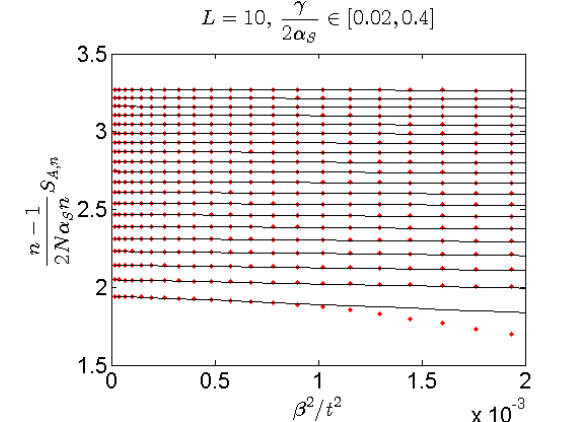
Figure 11 . Comparison of the numerical result (red dots) with the long time asymptotic behav- ior (5.19) (black lines) for L = 10 ; (cid:13) 2 [0 : 02 ; 0 : 4]. The curves with higher entropy has higher (cid:13) 2 (cid:11) S